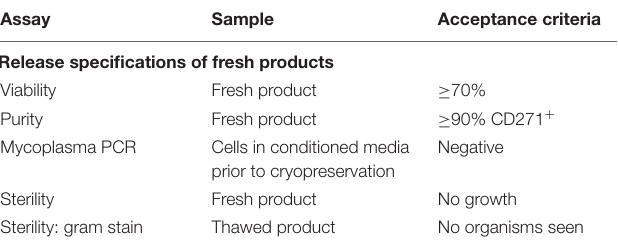
TABLE 3 | Release specifications of cryopreserved and thawed SC products.